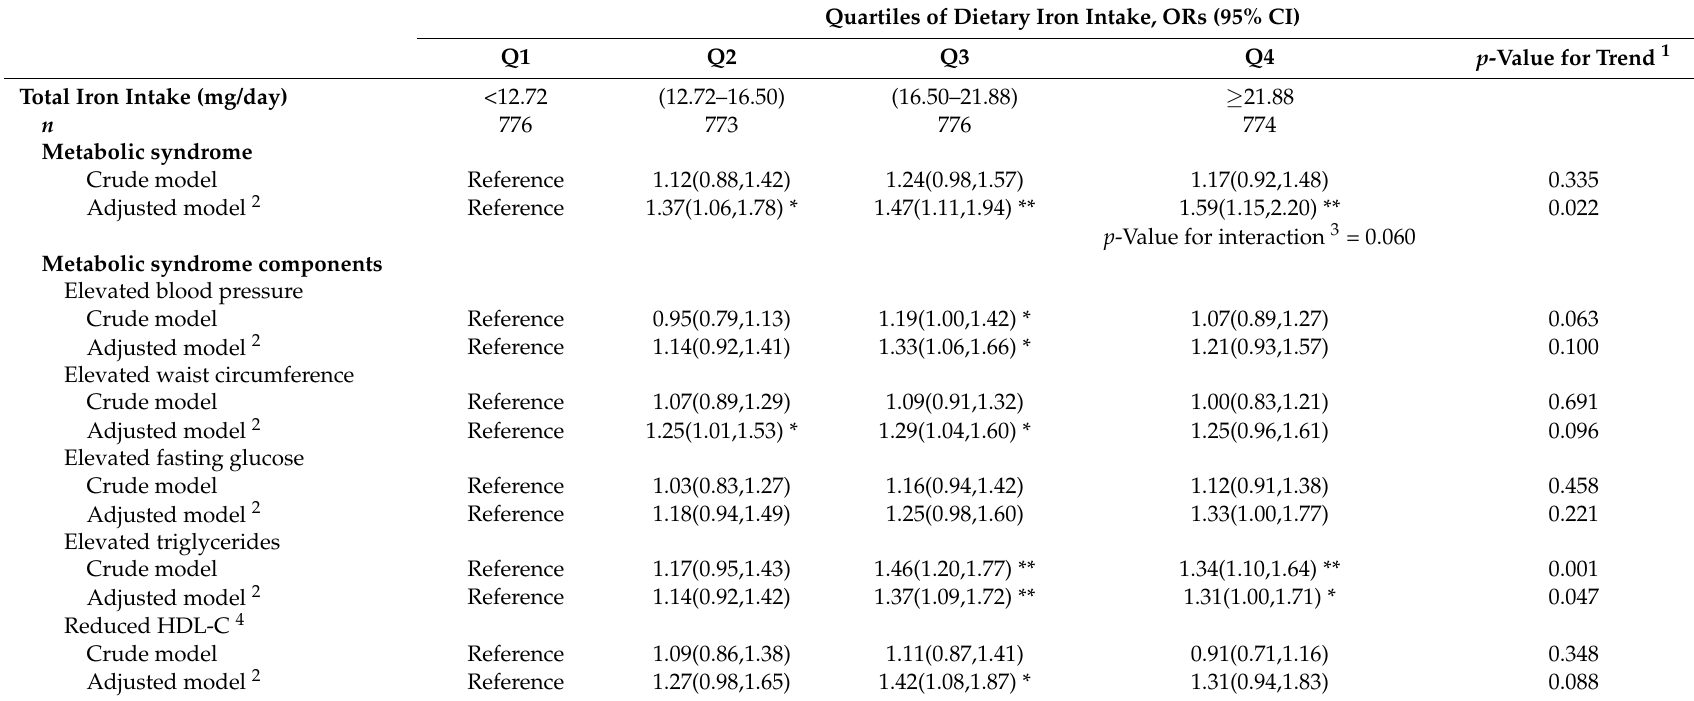
Table 2. Odds ratios (ORs) (95% CI) for metabolic syndrome and its components according to the quartiles of total iron intake (mg/day) among all participants in the SDHS